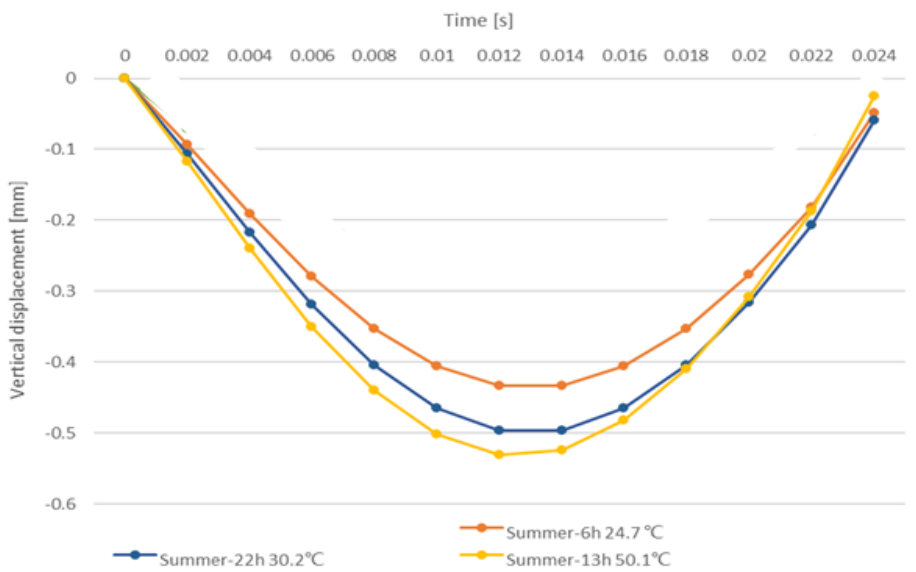
Figure 8. Vertical displacement of the center point of the asphalt surface course at different moments.